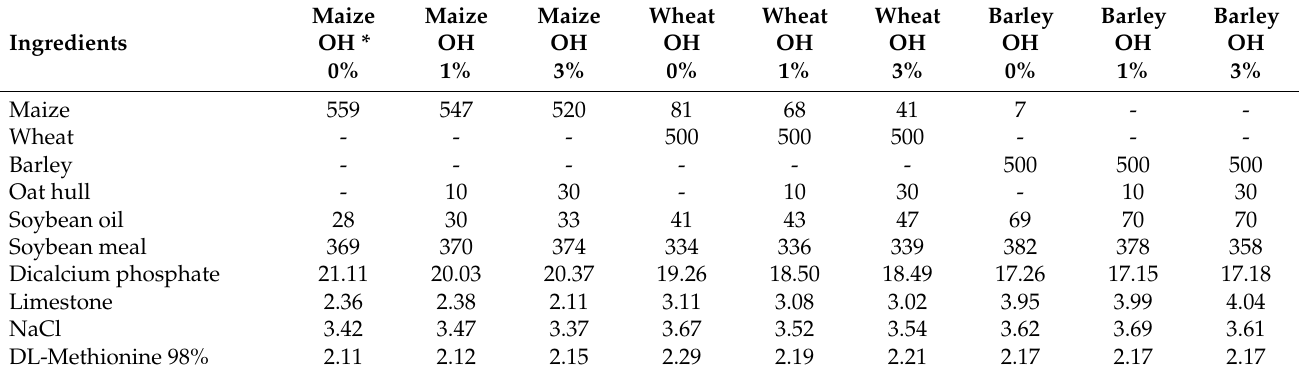
Table 3. Ingredient composition of diets (g · kg − 1